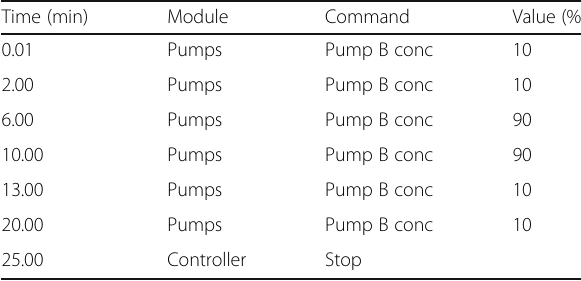
Table 1 Separation of samples based on the gradient applied in the HPLC